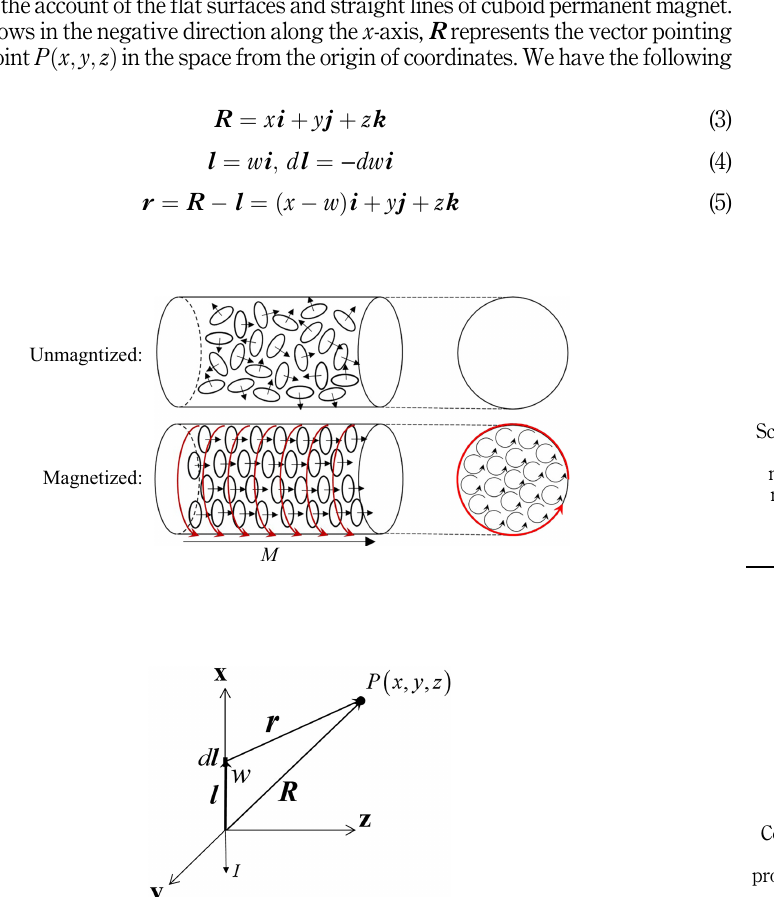
Figure 2. Coordinate system of magnetic field produced by a